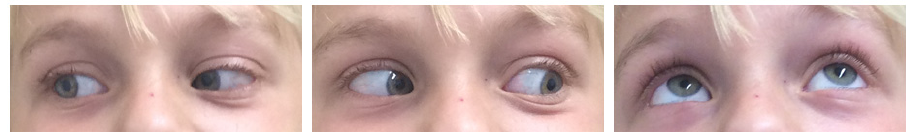
Figure 5. Exemplary photographs 2 years postoperatively with intact oculomotor function. Figure 6 provides exemplary photographs of a 2 ‐ year ‐ old child with a severe pre ‐ operative exophthalmos and good cosmetic result 13 days postoperatively.